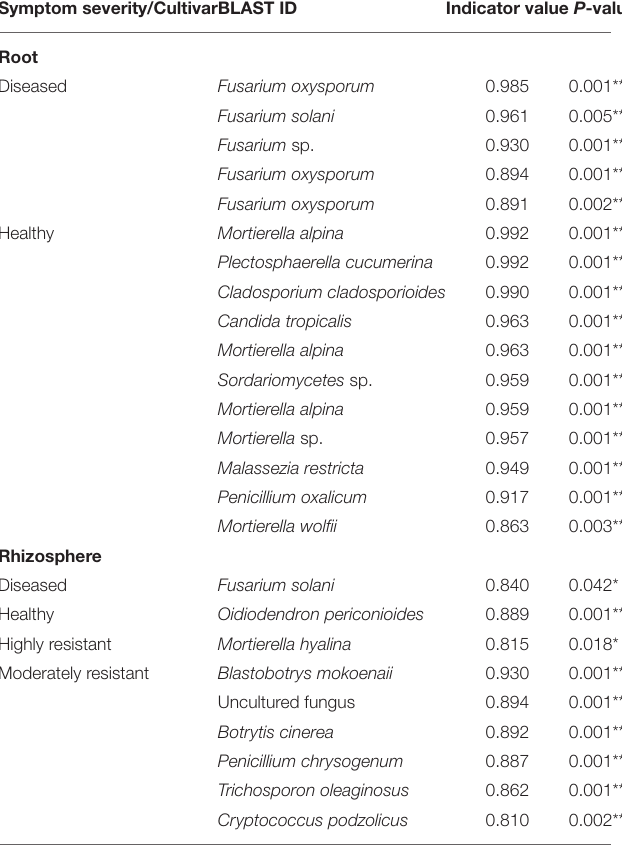
TABLE 2 | List of indicator species that were significantly different calculated using the Dufrêne and Legendre indicator species analysis conducted by the indicspecies package in